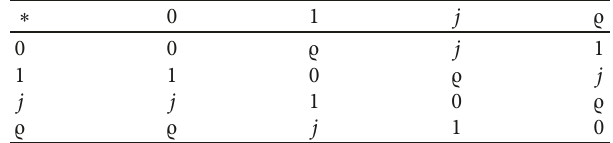
Table 1: Cayley table of the binary operation ∗ .